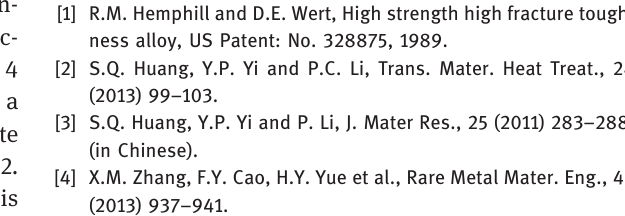
is 5 – 42%. The dynamic energy consumption behaviour of A100 steel clearly varies with the deformation tempera- ture and the strain rate. The η value increases gradually with the reduction in the rise of temperature and strain rate values. The calculation formula (cid:2) ð _ " Þ is shown in eq. (10). Plastic processing is unstable when (cid:2) ð _ " Þ < 0. The shaded areas in Figure 4 are the regions of (cid:2) ð _ " Þ < 0, which are thermal processing hazardous areas. The instability area for the steady-state rheological instability in the figure is mainly concentrated in the high-strain-rate zone and in the low-temperature and high-strain rate zone.